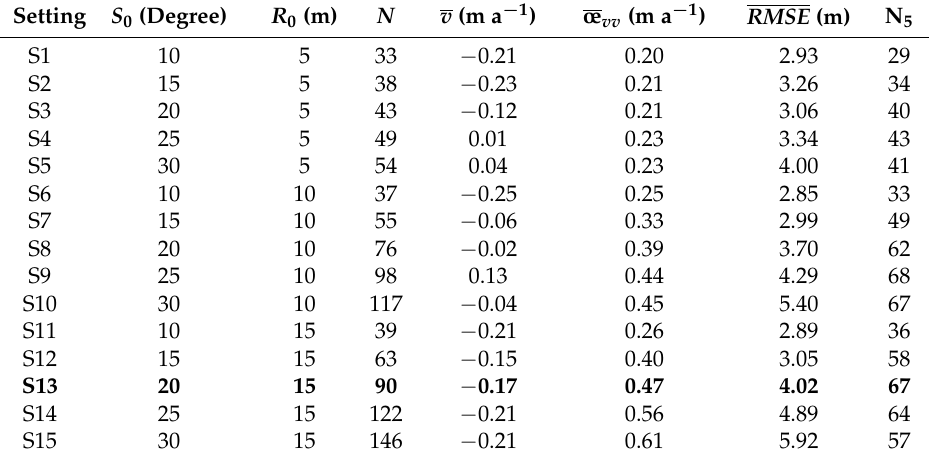
Table 2. Settings of terrain surface parameters for filtering ICESat